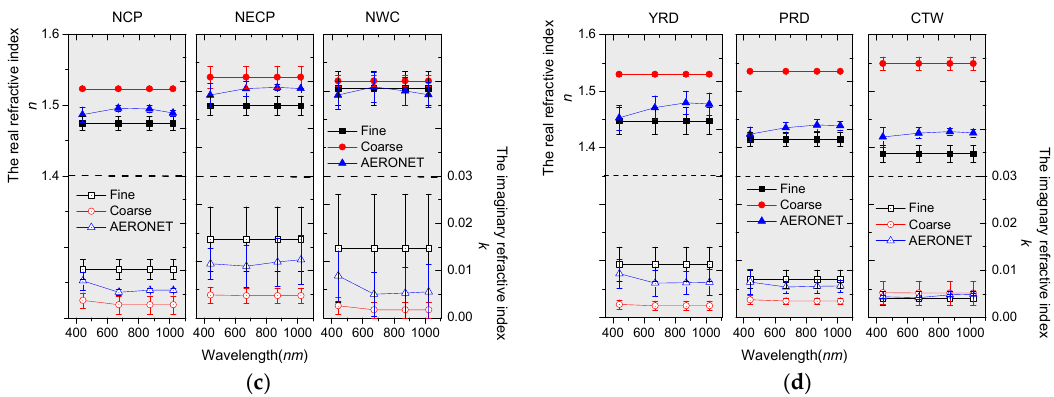
Figure 5. Estimation results of modal m values over China. ( a ) Geographical information, ( b ) annual mean AOD0. 44 and AROD, ( c ) modal m values in NCP, NECP, and NWC, and ( d ) modal m values in PRD, YRD, and CTW; AOD 0.44 and AROD represent aerosol optical depth at 0.44 µ m and aerosol relative optical depth.